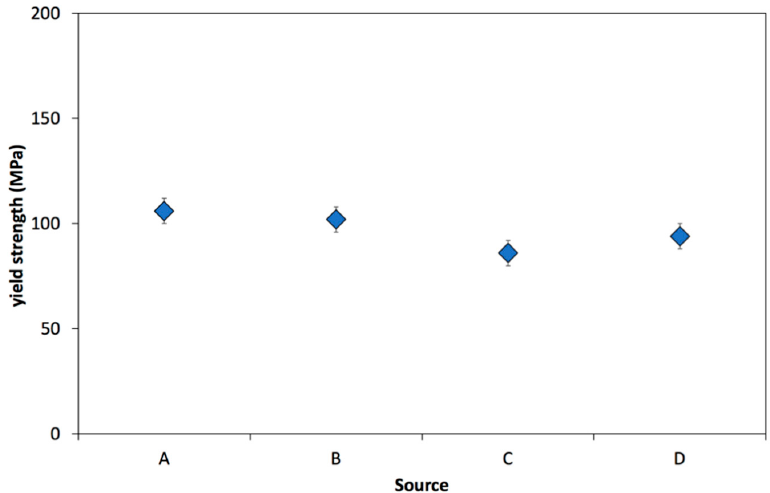
Figure 4. Change in yield strength with source.